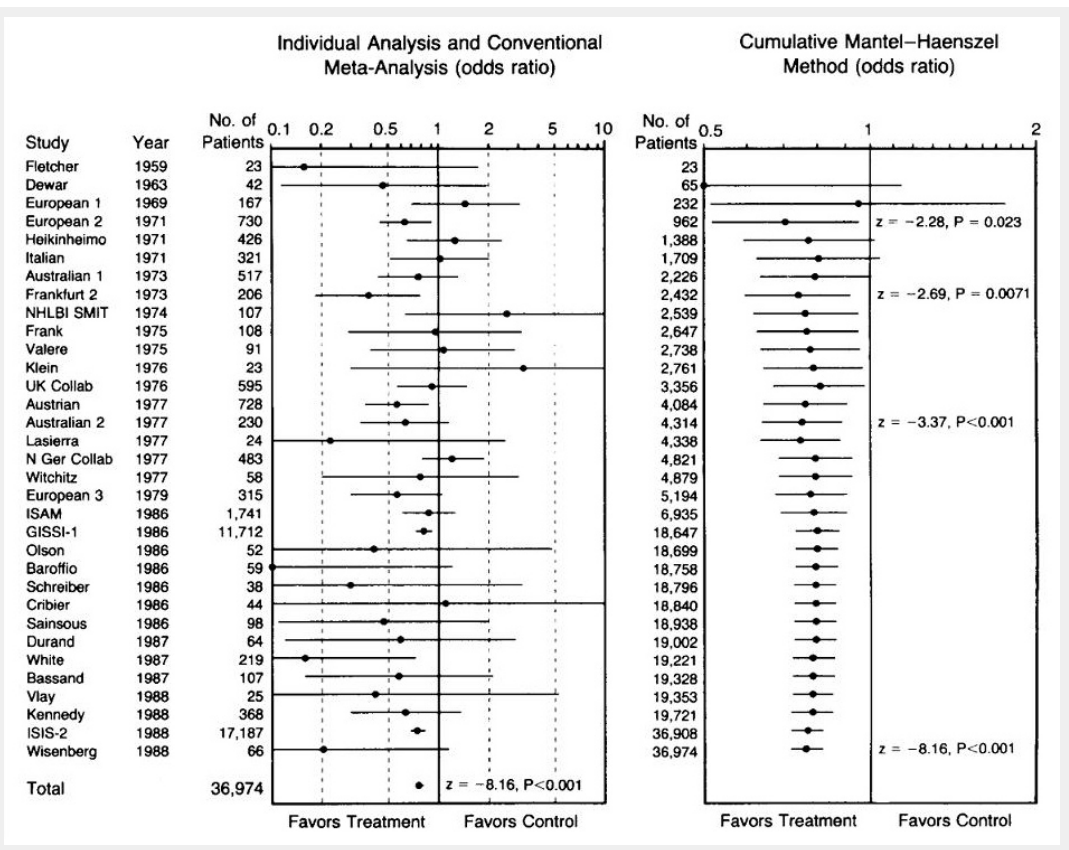
Figure 3 Conventional and cumulative meta-analyses of 33 trials with intravenous streptokinase for acute myocardial infarction. The odds ratios and 95% confidence intervals for an effect of treatment on mortality are shown on a logarithmic scale (from [19], Lau J, Antman EM, Jimenez-Silva J, et al. Cumulative meta-analysis of therapeutic trials for myocardial infarction. N Engl J Med. 1992;327:248–54. Reprinted with the permission from the Massachusetts Medical Society